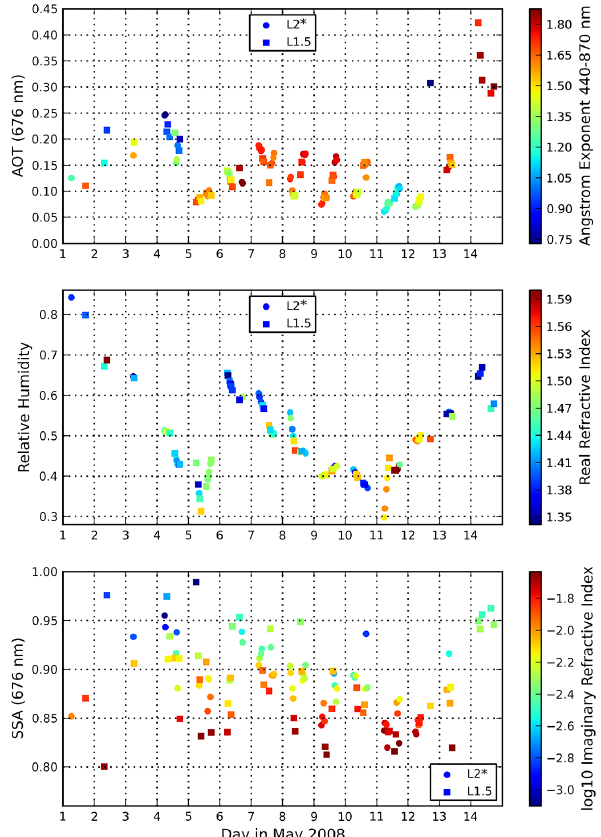
Figure 2. AERONET almucantar retrieval data (level 1.5: squares; L2*: dots) during the first 14 days of May 2008 at the Cabauw Tower. (a) Aerosol optical thickness (AOT) color-coded with val- ues of the Ångström exponent (440–870nm), (b) the columnar rel- ative humidity from balloon soundings between 0 and 2km color- coded with the AERONET real part of the refractive index, and (c) AERONET single-scattering albedo (SSA) color-coded with the (base 10 logarithm) imaginary part of the refractive